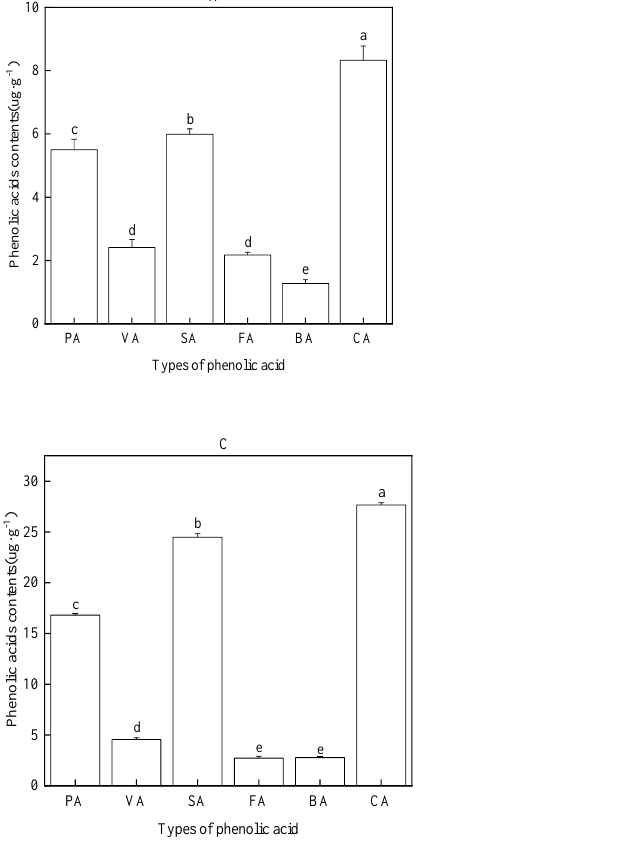
Figure 5. Types and contents of phenolic acids in the water extract of faba bean roots ( A ), stems ( B ), leaves ( C ), and rhizosphere soil ( D ). Data are expressed as the mean ± standard error of three biological replicates. Various letters for each index indicate significant differences at p < 0.05.